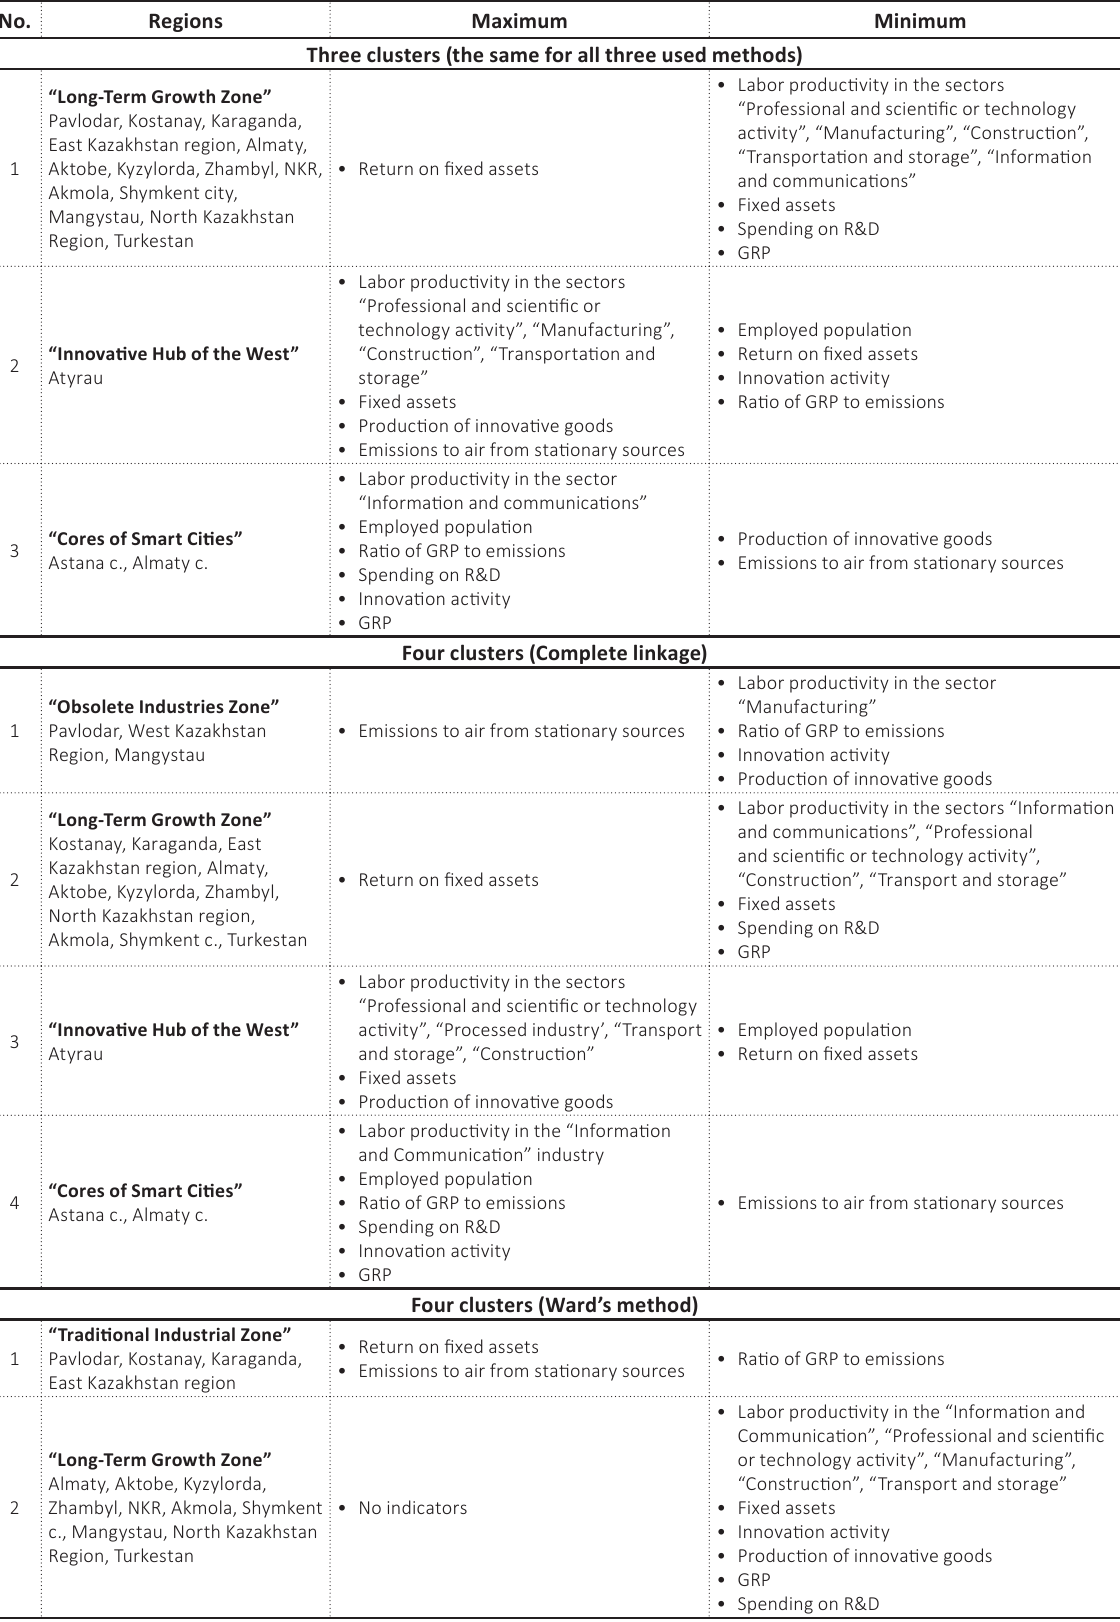
Table 1. Description and interpretation of the regional clusters of Kazakhstan Source: Authors’ elaboration. No. Regions Maximum Minimum Three clusters (the same for all three used